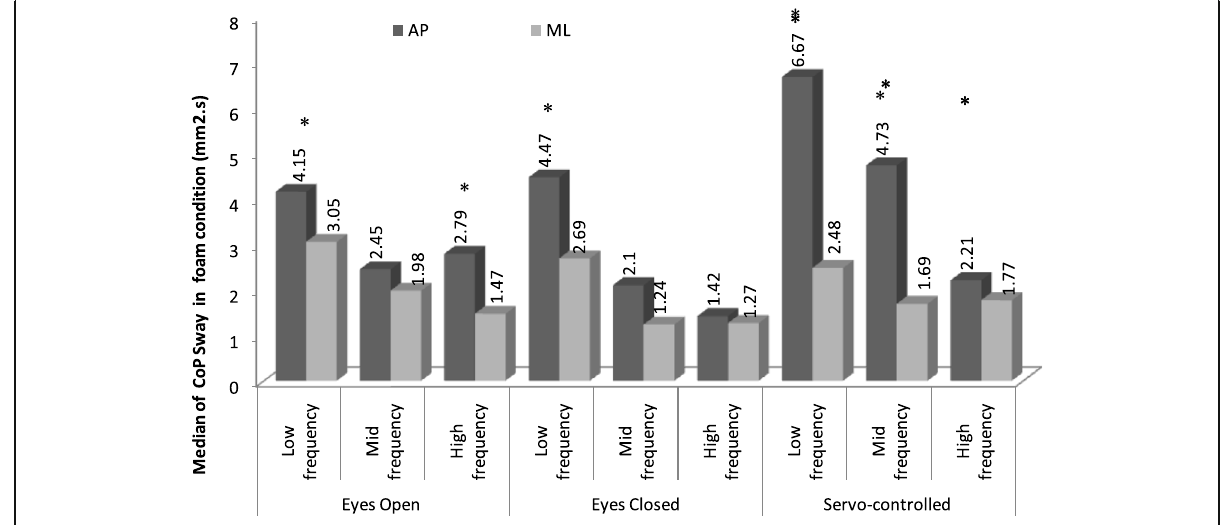
Fig. 4 Comparison of FFT of AP and ML sway in the study group in the foam